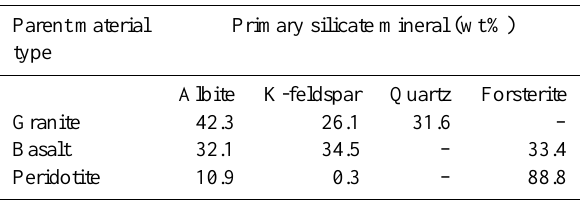
Table 2. Primary minerals and their relative weight composition. The oxide weight composition typical of granite, basalt and peri- dotite was obtained from literature (Blatt and Tracy, 1996; Harris et al., 1967; Hartmann et al., 2013). The mineralogical compositions were estimated from these data using the normative mineralogy cal- culation method (Cross et al., 1902; Kelsey,